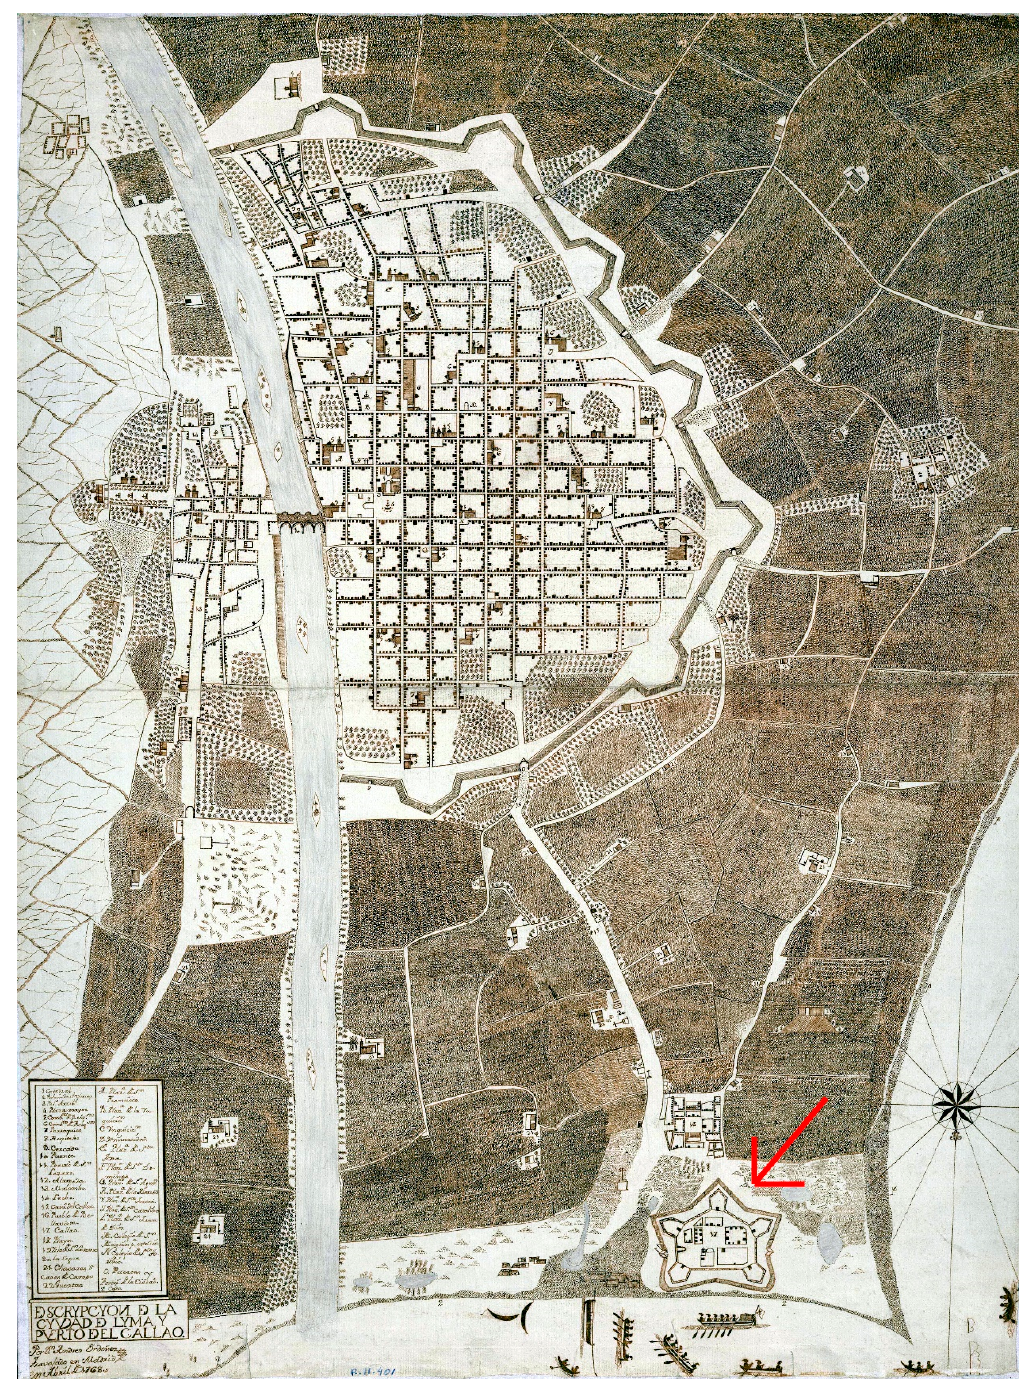
Figure 11. A 1768 copy by Ordo ň ez [41] of a map of Lima and surroundings (1747–1768), with Real Figure 11. A 1768 copy by Ordoˇnez [41] of a map of Lima and surroundings (1747–1768), with Real Felipe fort (see red arrow) built on the site where Callao was present (courtesy: Biblioteca Nacional Felipe fort (see red arrow) built on the site where Callao was present (courtesy: Biblioteca Nacional de Espana). de